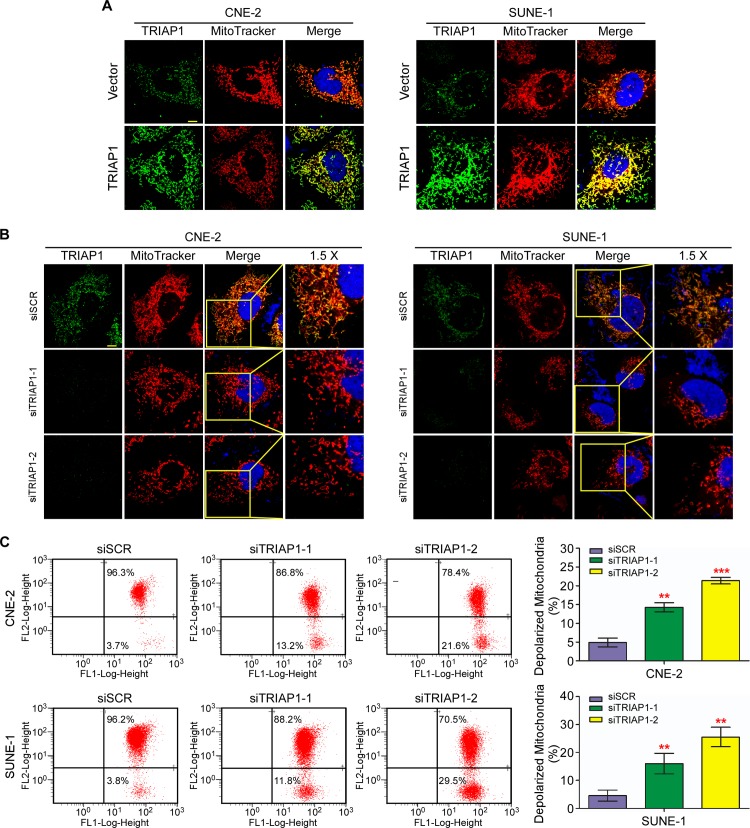
TRIAP1 regulates mitochondrial fragmentation and membrane potential.A and B, Representative images of mitochondria and TRIAP1 subcellular location for CNE-2 (left panel) and SUNE-1 (right panel) cells transiently transfected with an empty vector (upper panel) or TRIAP1 (lower panel) (A); or siSCR, siTRIAP1-1 or siTRIAP1-2 (B) after stained with MitoTracker Red and TRIAP1 primary antibody. Scale bar, 10 μm. (C) Representative dot plots (left panel) and quantification (right panel) of mitochondrial membrane potential of TIRAP1 knockdown in CNE-2 and SUNE-1 cells subjected to JC-1 staining. The percentage of cells with FL1-positive and FL2-negative signals represents depolarized mitochondrial cells. Each experiment was independently repeated at least three times. The data are presented as the mean ± s.d. Student’s t-test, ** P < 0.01, *** P < 0.001.